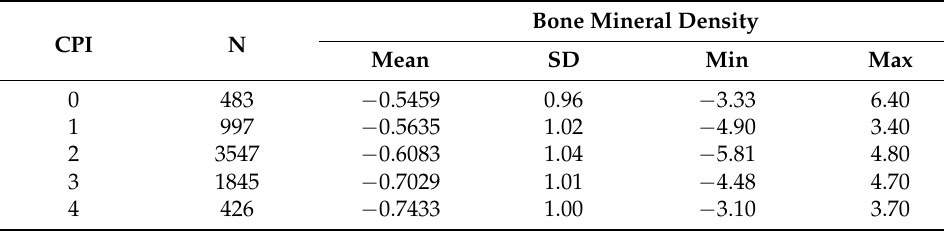
Table 2. The distribution of bone mineral density by the community periodontal